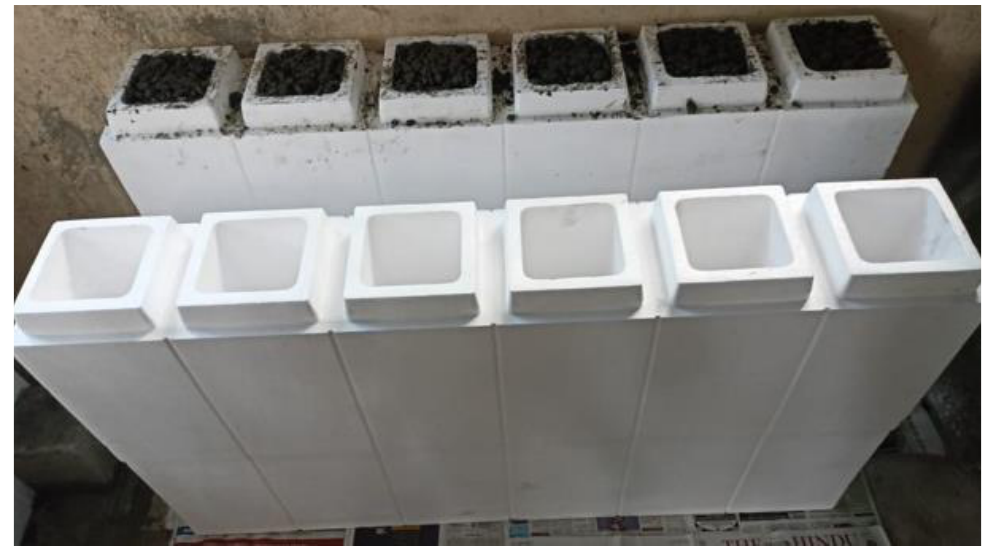
Figure 4. The casting of the